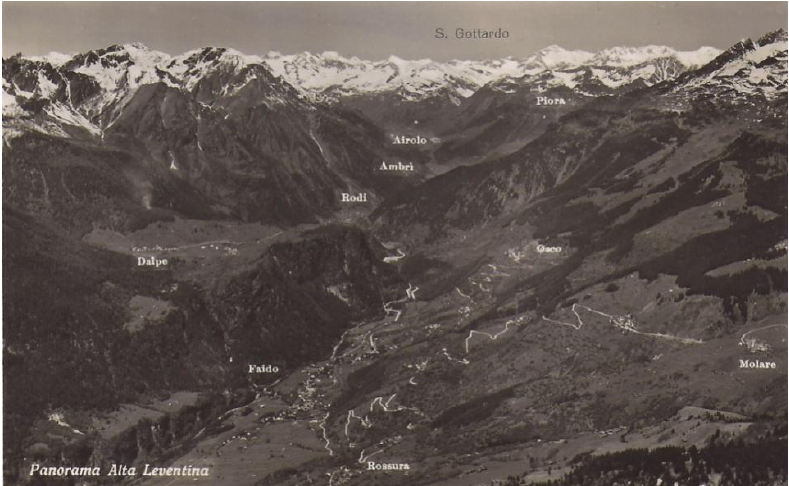
Figure 2. Photograph of the western-lower part of the deep-seated landslide in Osco around 1940 when the forest cover was much less dense than